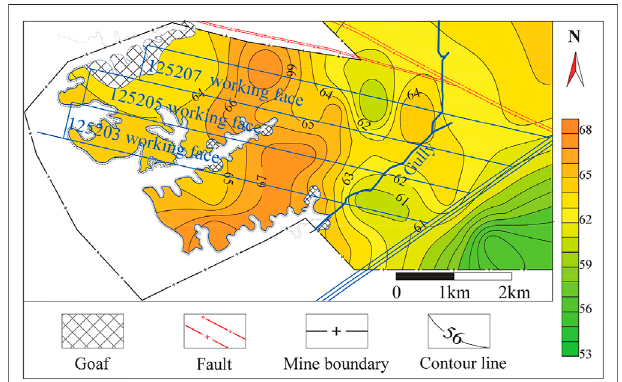
FIGURE 7 | The contour map of 5 − 2 WCFZ development.